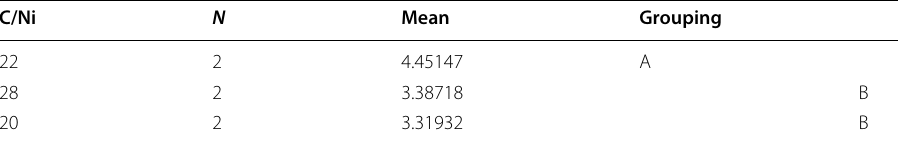
N sample size. Means that do not share a letter are significantly different